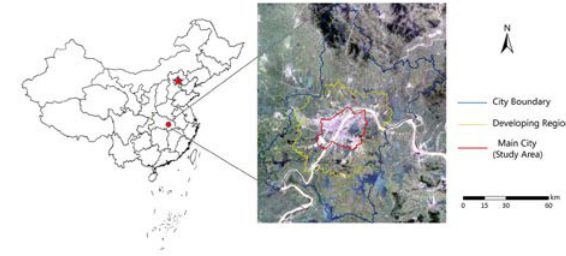
Figure 1. Location of the study